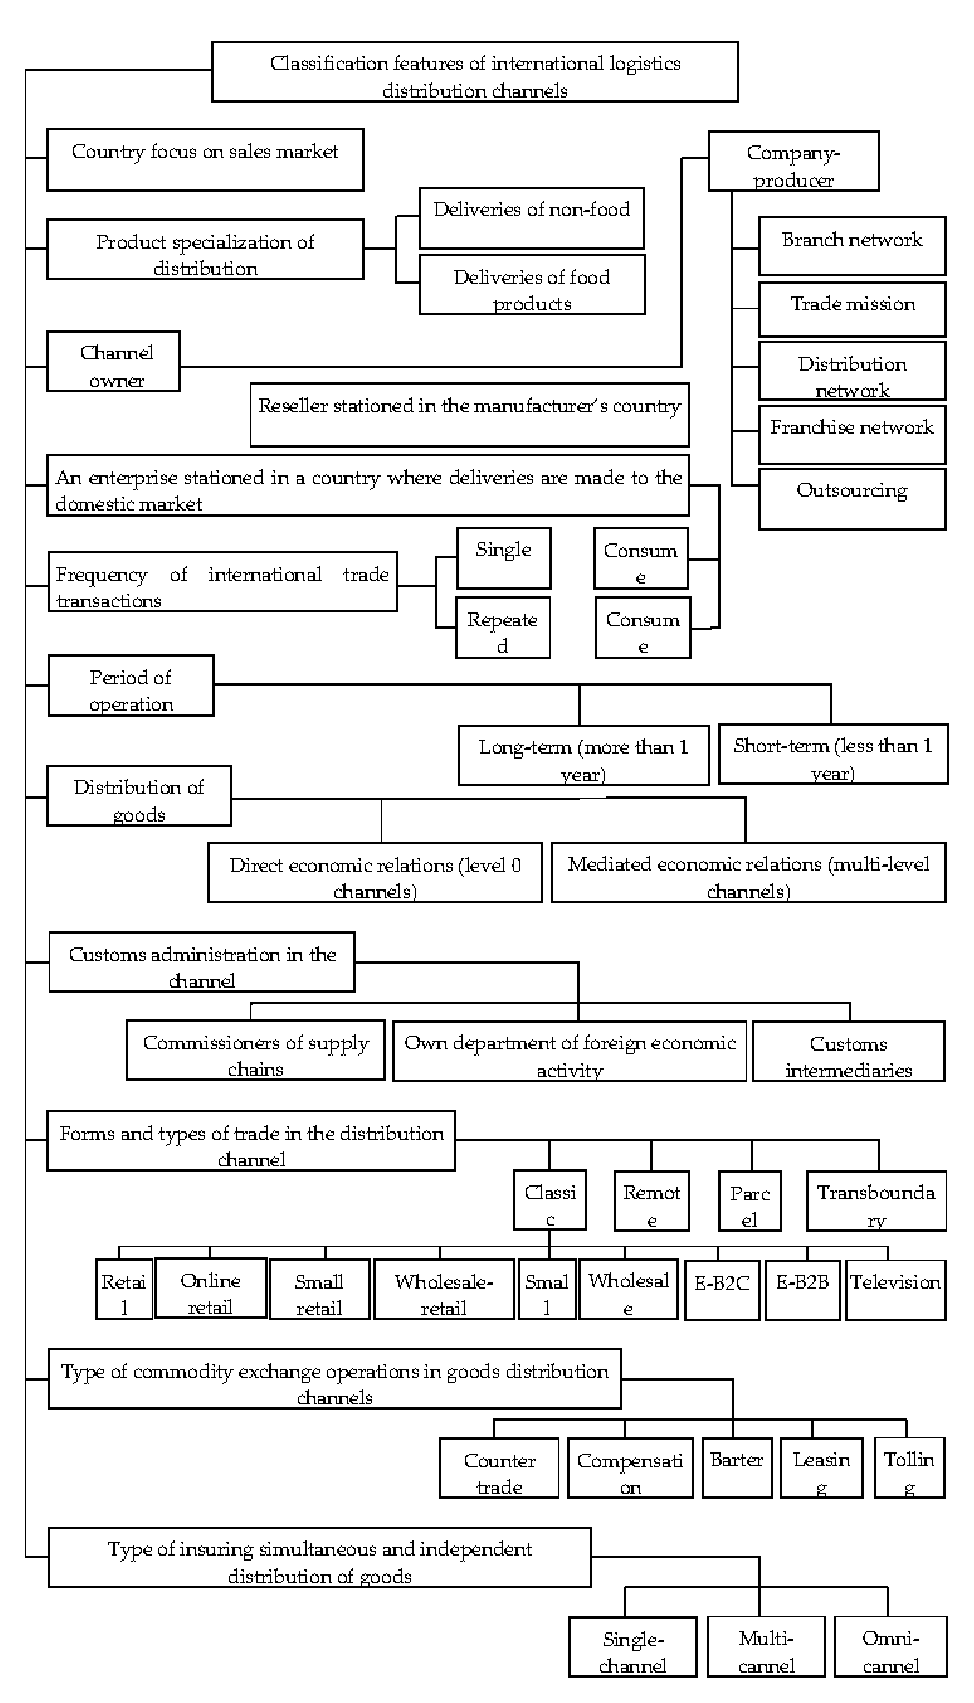
Figure 7. Classification of international logistics distribution channels.